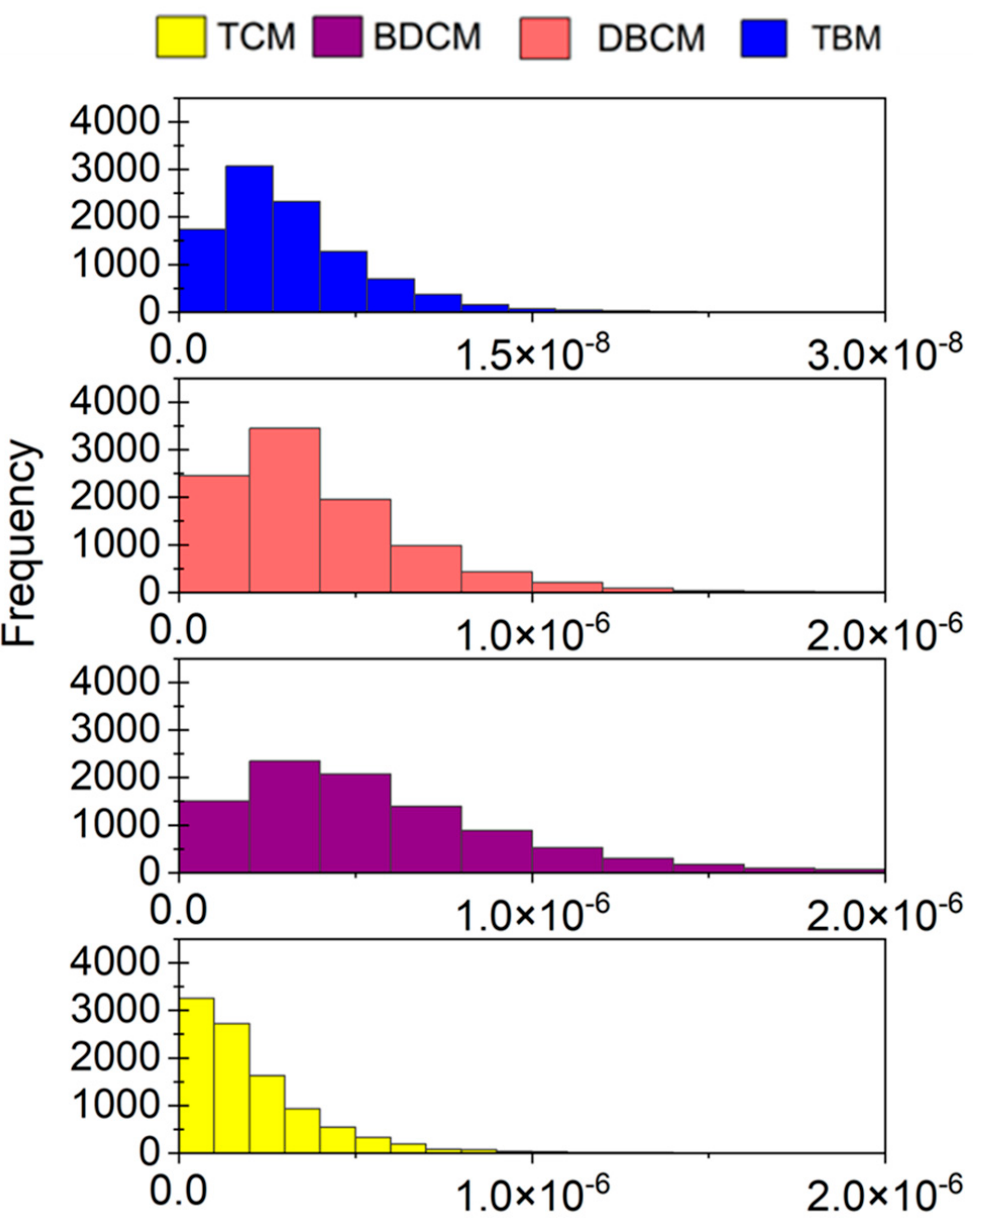
Figure 4. Frequency distribution of cancer risk through inhalation in the case of private shower rooms. TCM: trichloromethane, BDCM: bromodichloromethane, DBCM: dibromochloromethane, and TBM: tribromomethane.